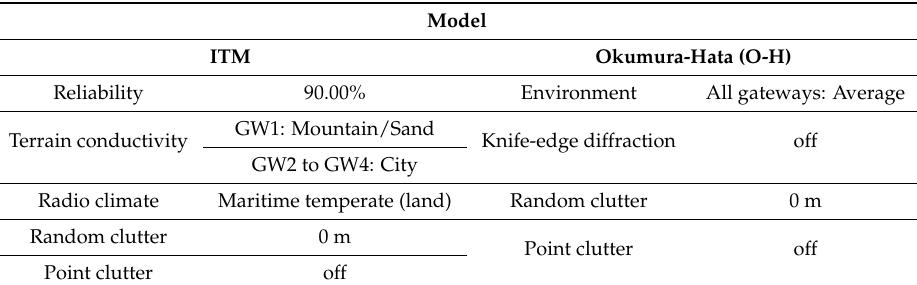
Table 5. CloudRF propagation models parameters.